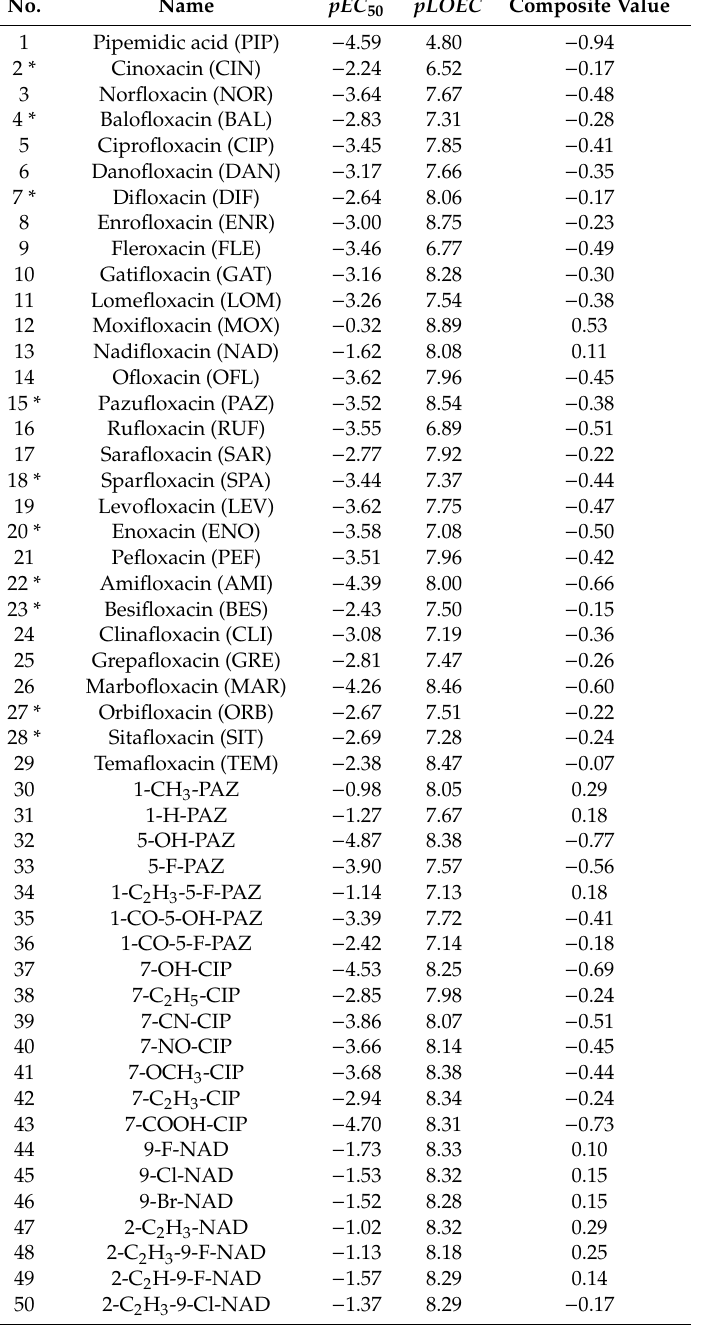
Table 1. Green algae toxicity, bacterial genotoxicity, and double-activity characterization values of quinolones.